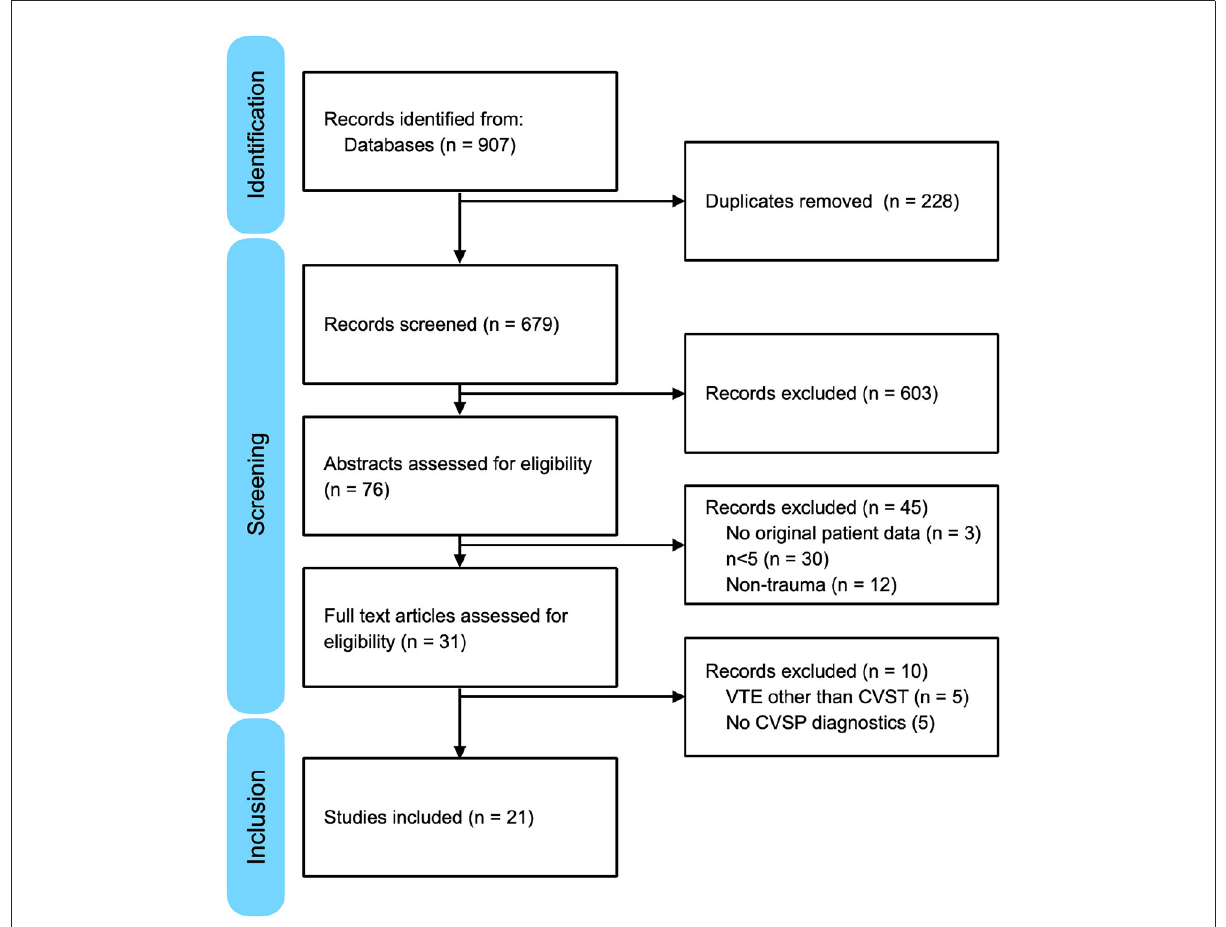
FIGURE1 PRISMA flow diagram detailing identification, screening and inclusion of